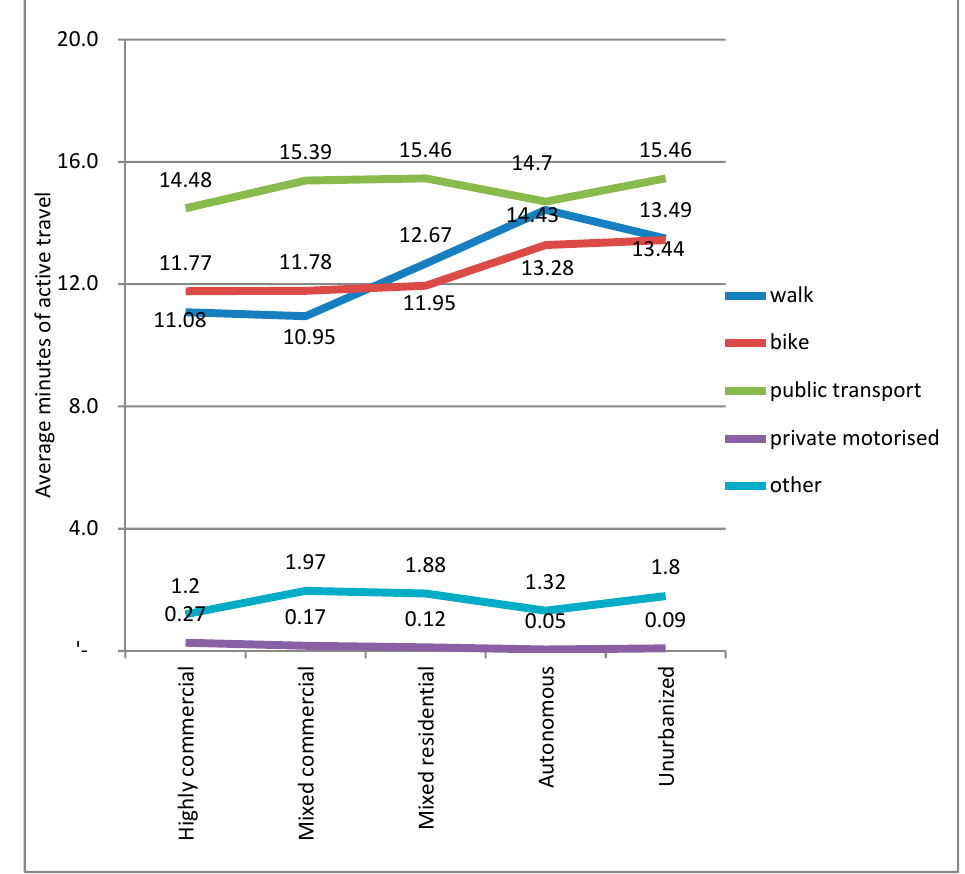
Figure 5. The average active travel time per mode by built environment type.